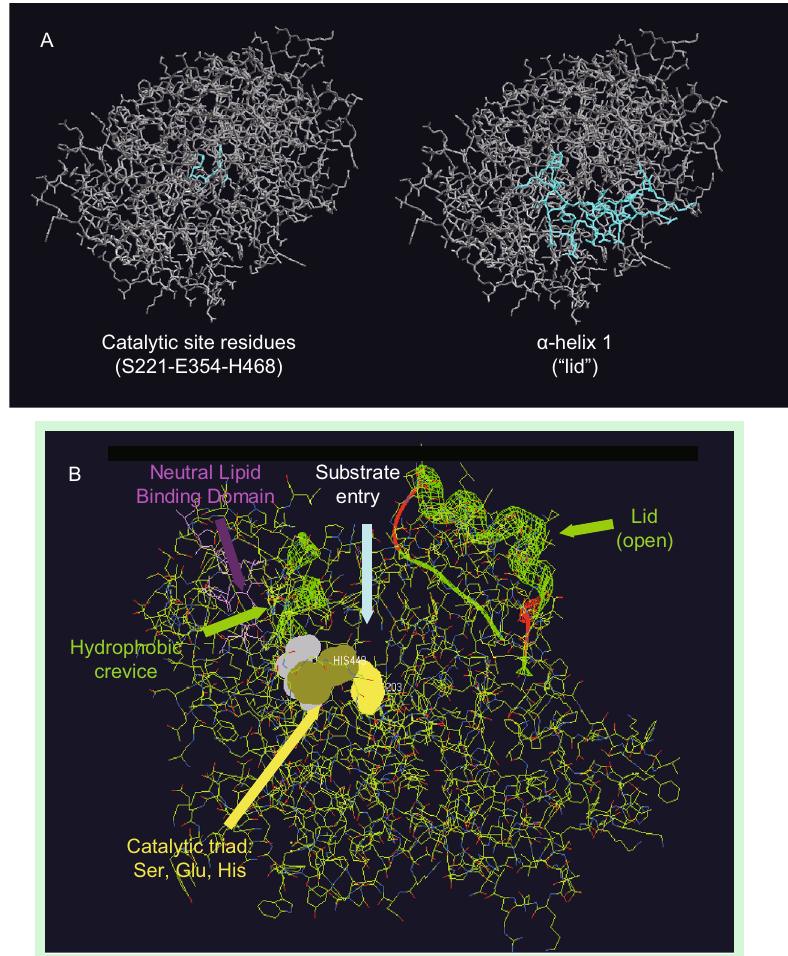
Figure 2. Three-dimensional structure of human CES1.